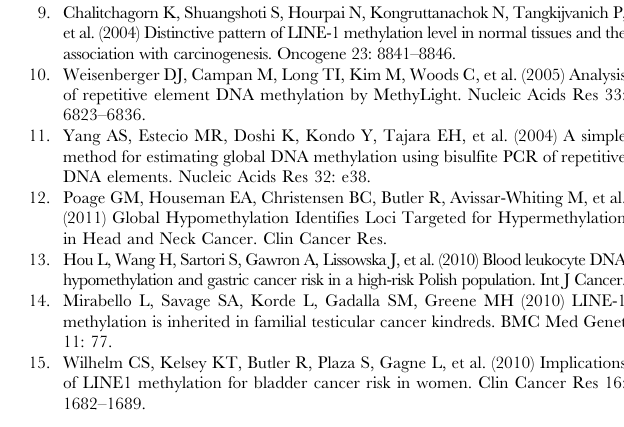
Figure S1 Sample pyrogram demonstrating LINE-1 methylation levels. Table S1 Stratified Analyses by Smoking Status and Individual LINE-1 position. Odds ratios and 95% confidence intervals for the association between LINE-1 methylation levels and RCC, adjusted for sex, age, center, BMI, high blood pressure and vegetable